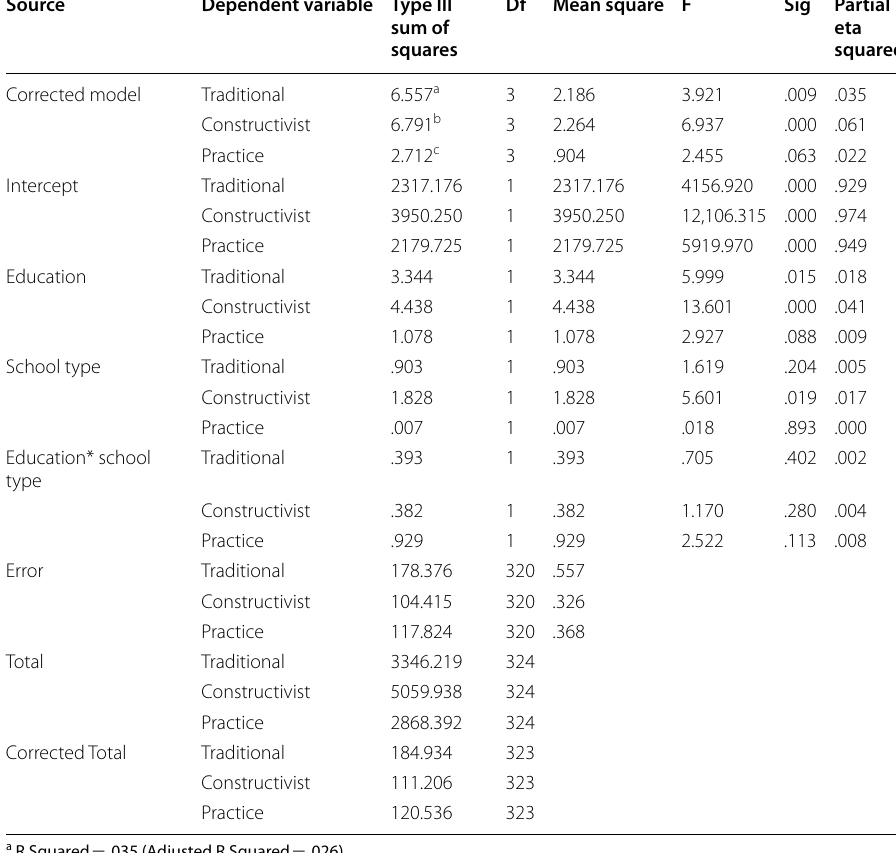
Table.6 Results of test of between subject effects according to education level and school type